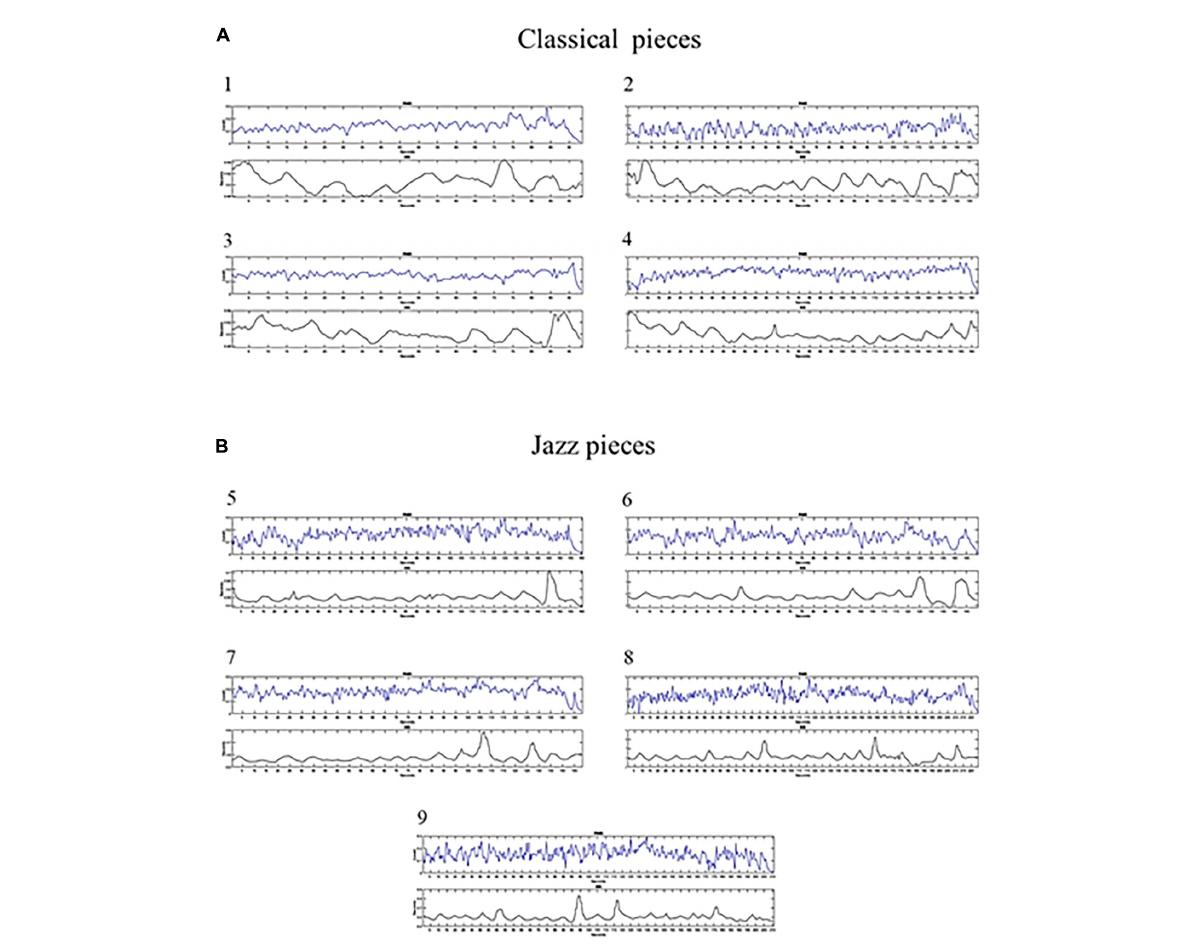
FIGURE3 Figure shows the time course of the music volume envelope (upper panel) and the RR time series (lower panel) of the 9 pieces [1–4 classical pieces, (A) ; 5–9 jazz pieces, (B)